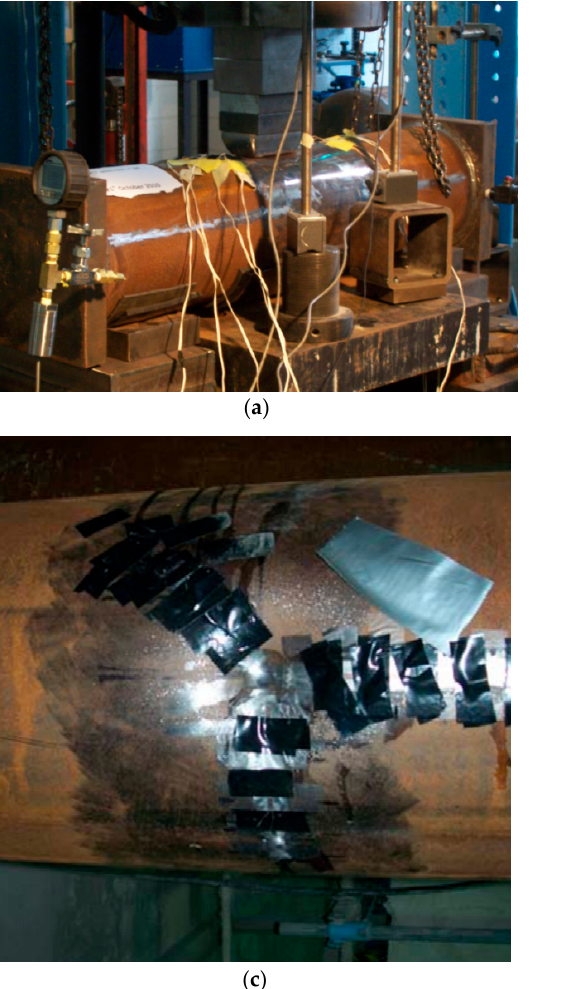
Figure 3. The dented pipe test photo and strain gauges arrangement: ( a ) test equipment, ( b ) semi- spherical indenter, ( c ) dented pipe and strain gauge arrangement, ( d ) schematic diagram of strain gauge arrangement [16].